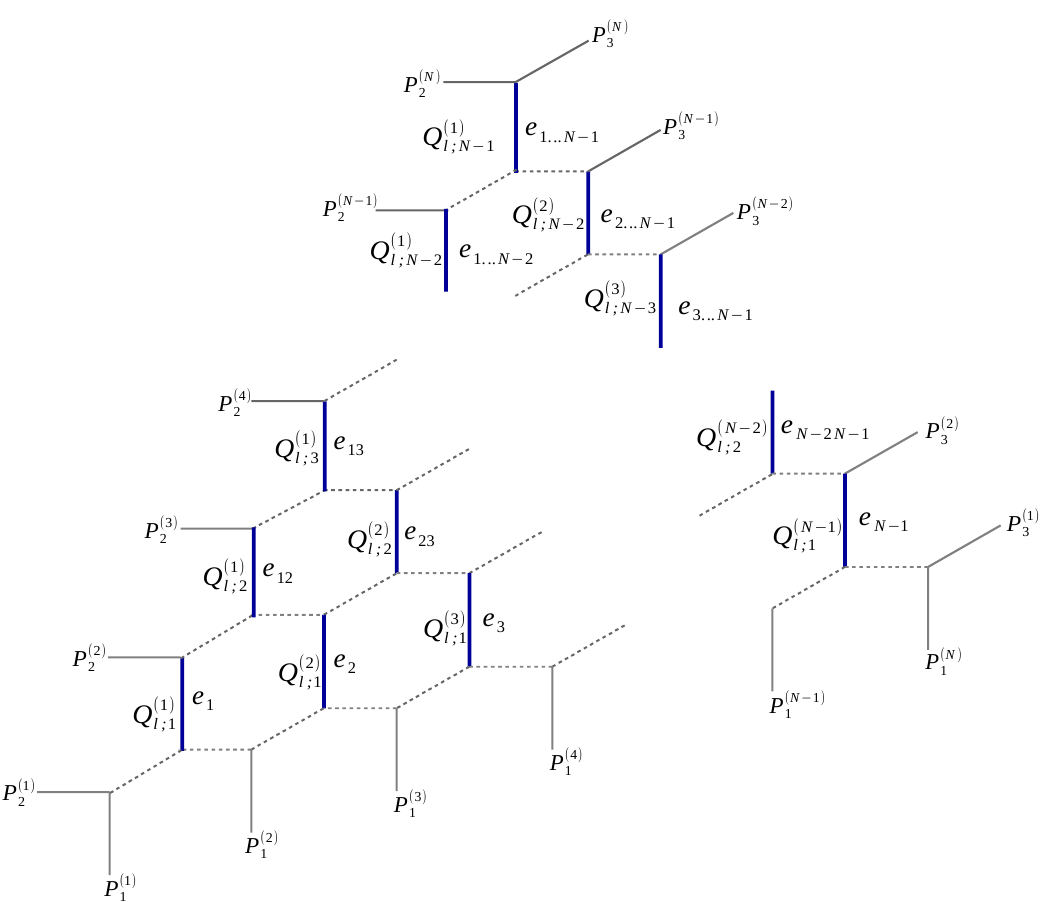
Figure 14 . T N web diagram with an assignment of K(cid:127)ahler parameters to the inner vertical seg- ments, the positions of the external semi-in(cid:12)nite branes, and the assignment among the K(cid:127)ahler parameters Q ( p ) and positive roots e ij = P j e k , for e k simple roots of the Lie algebra sl N , k = i l ; q k = 1 ; : : : ; N (cid:0)